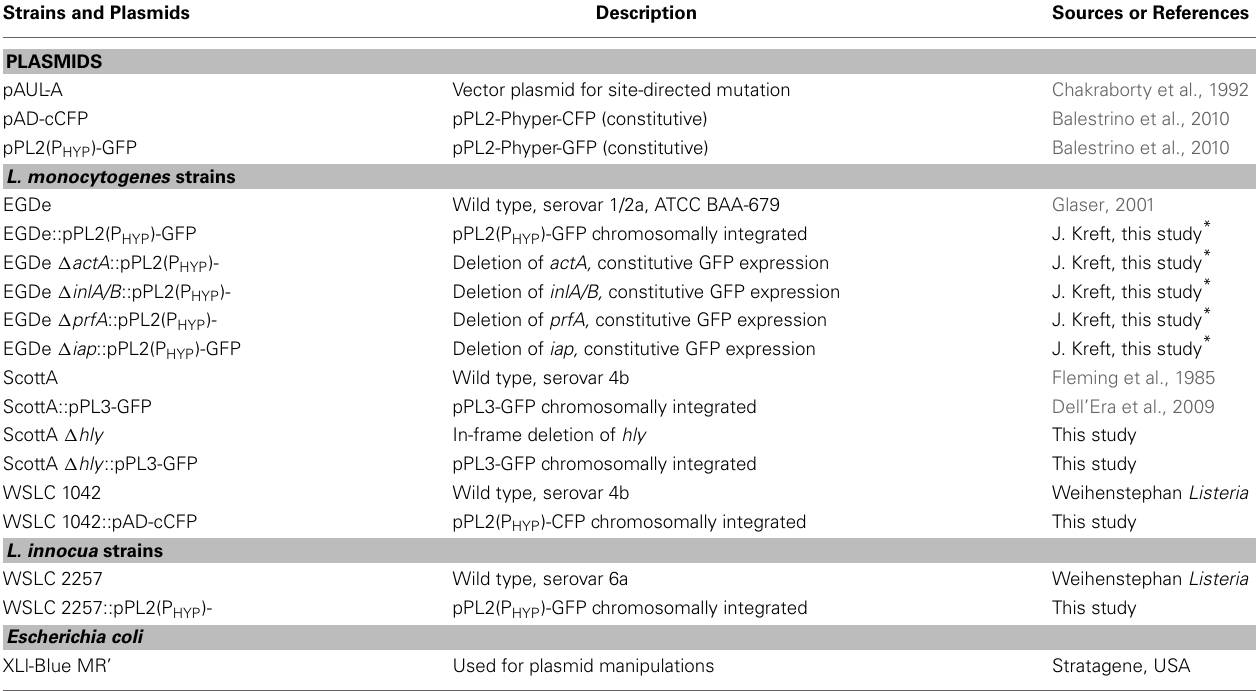
Table 1 | Plasmids and strains used in this study. Strains and